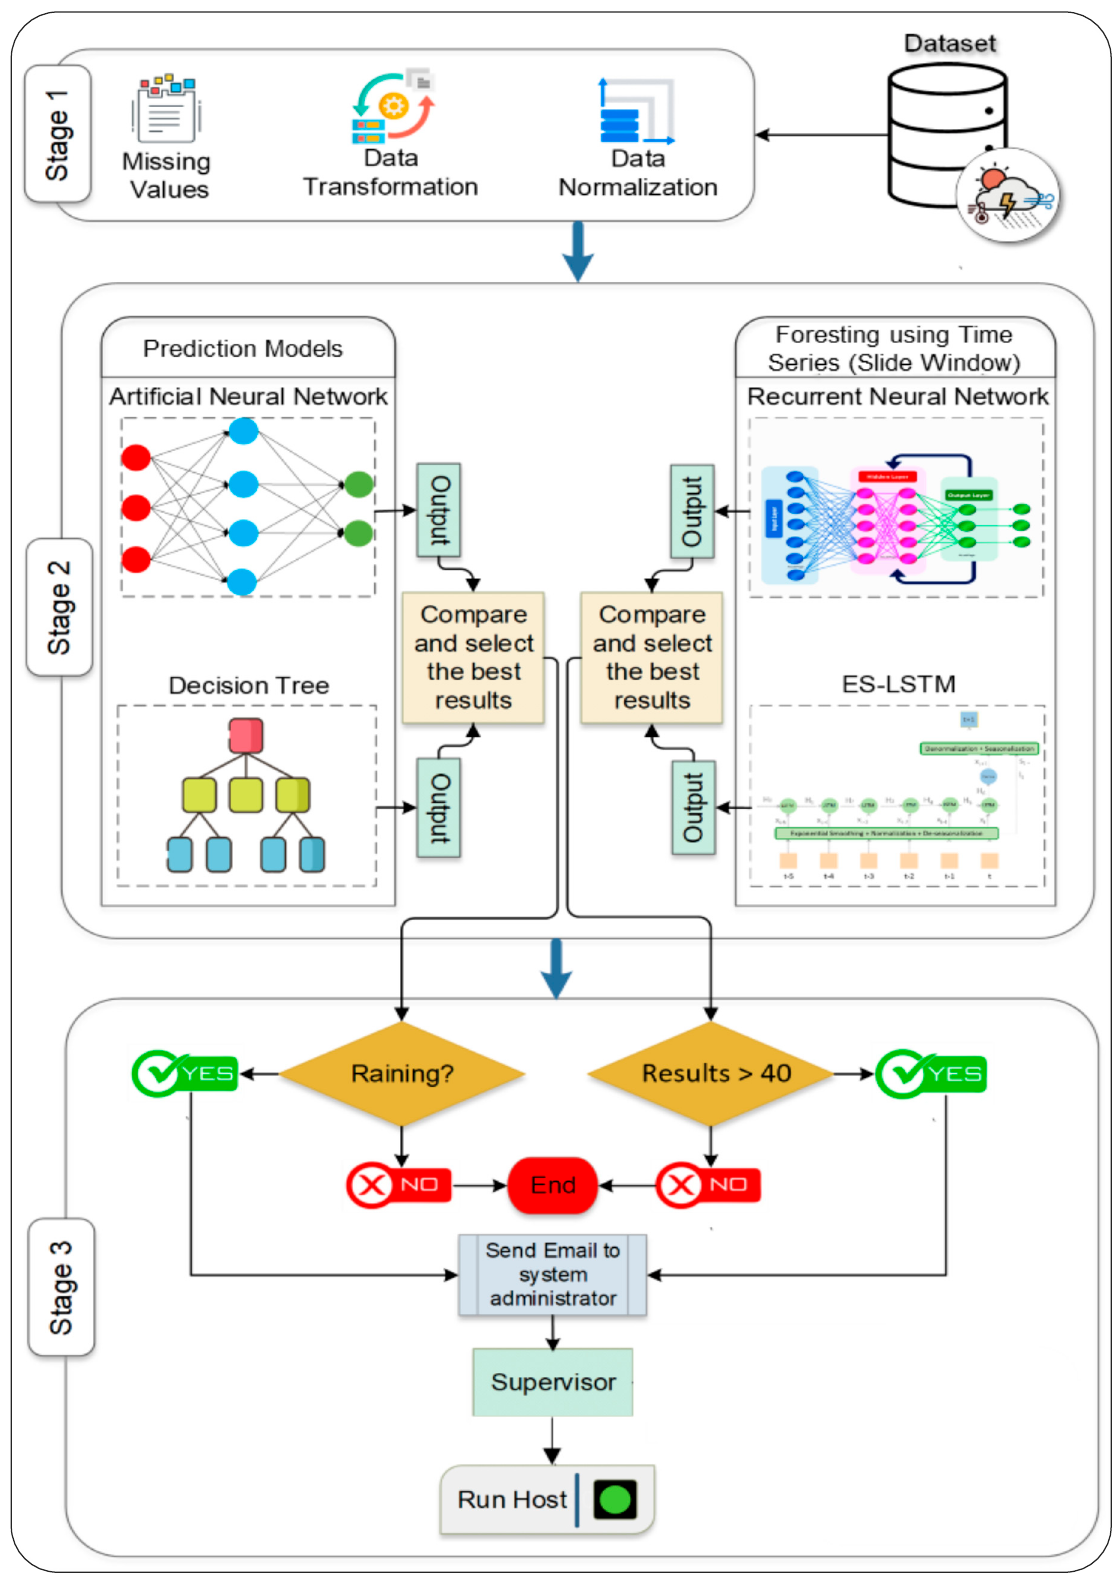
Figure 7. The methodology of the proposed approach.